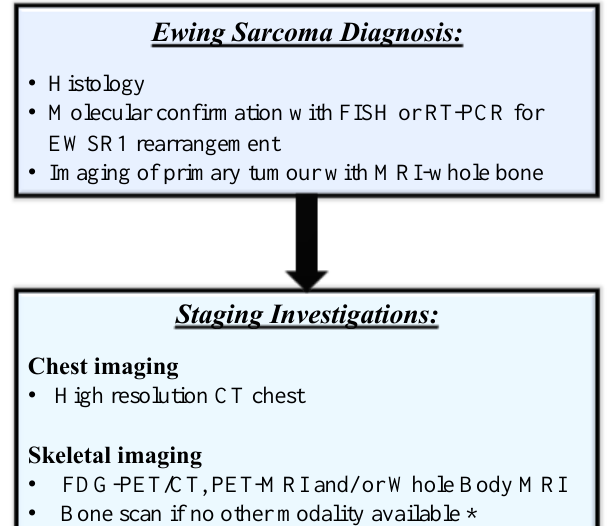
Figure 2. Staging algorithm for patients with Ewing sarcoma undergoing standard of care treatment. * If bone scan only available, consider bone marrow: patients with oligometastatic disease being considered for radical local therapy to all sites. FDG-PET = fluorodeoxyglucose positron emission tomography, WB-MRI = whole body magnetic resonance imaging.